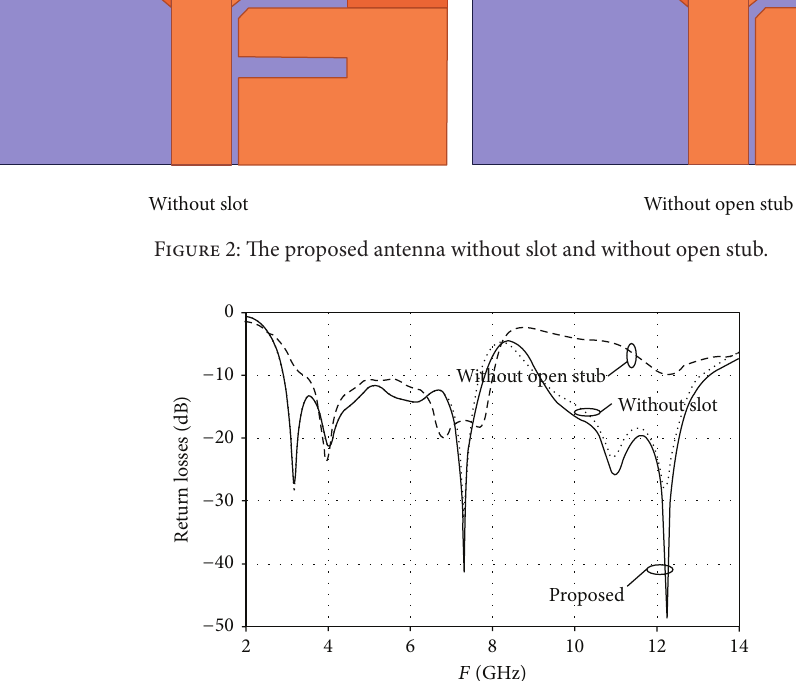
Figure 3: Simulated return losses of the proposed antenna, without open stub antenna, and without slot antenna.